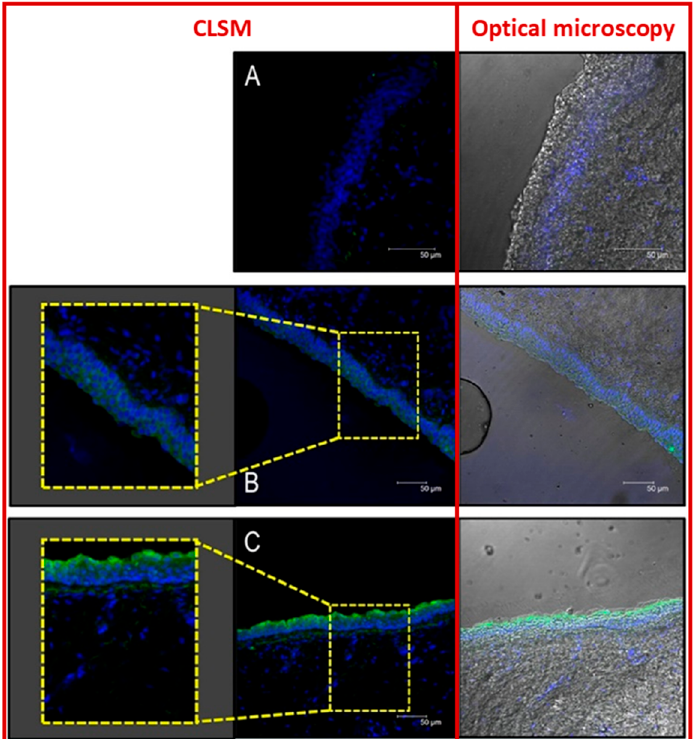
Figure 6. CLSM (confocal laser scanning microscopy) images of porcine vaginal mucosa alone ( A ), placed in contact with a solution of insulin-FITC ( B ) and with a suspension of insulin-FITC loaded CS NPs ( C ). Zoom of a CLSM picture detail and an overlap with a micrograph of the same mucosa zone obtained by optical microscope.